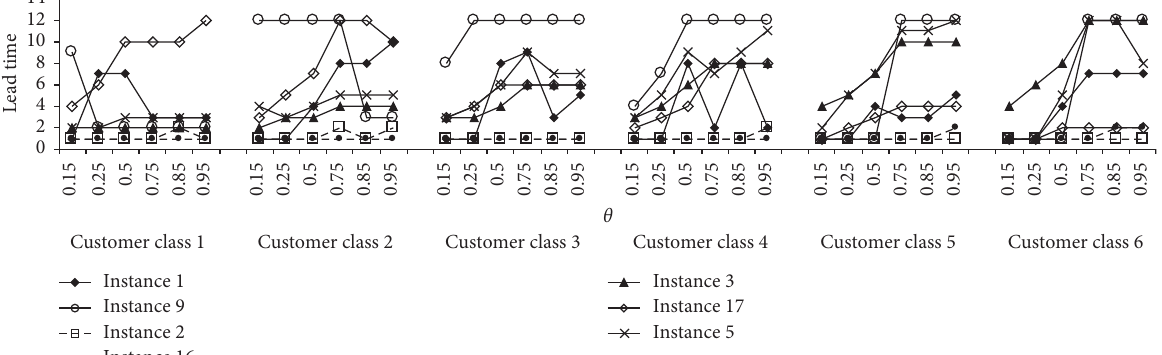
Figure 6: Comparison of the optimal quoted lead time in decentralized dual-channel supply chain for different instances.